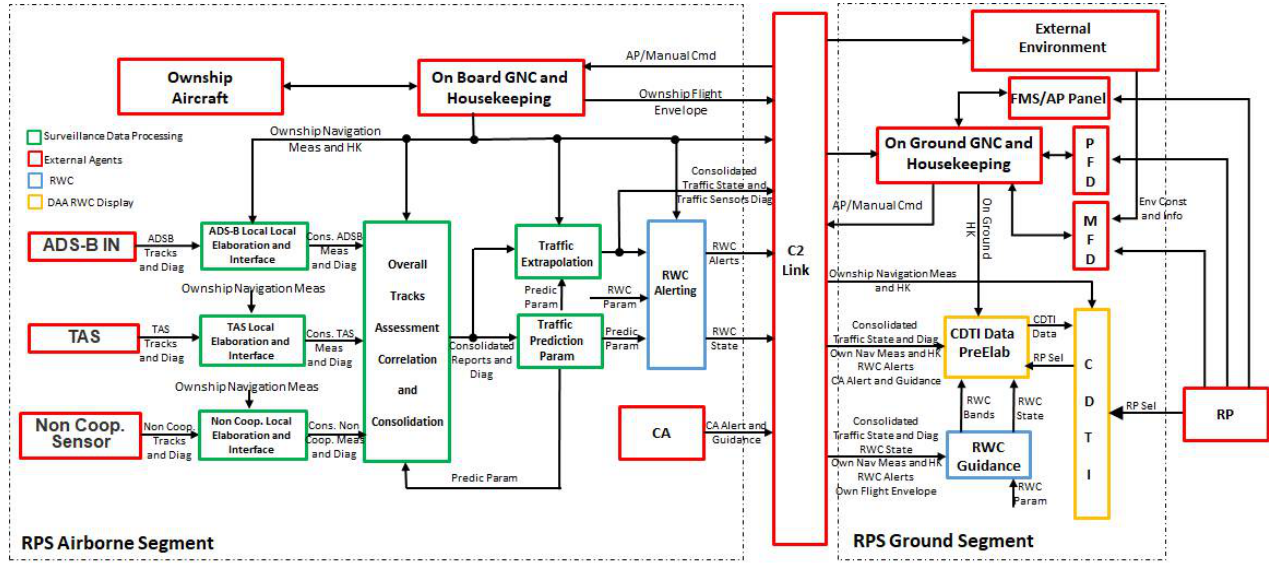
Figure 4. RWC detailed functional architecture.